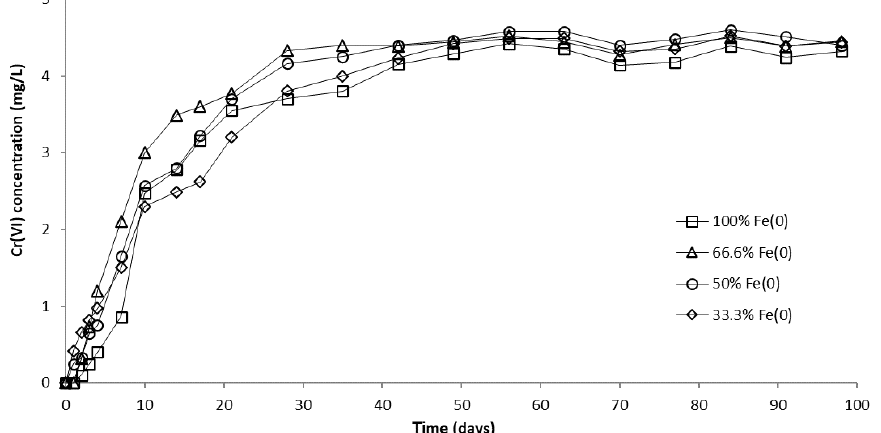
Figure 10. Cr VI concentration in column effluent vs. time for columns having fixed Fe 0 volume and variable total reactive zone volume V 2 at initial pH 7.1 .